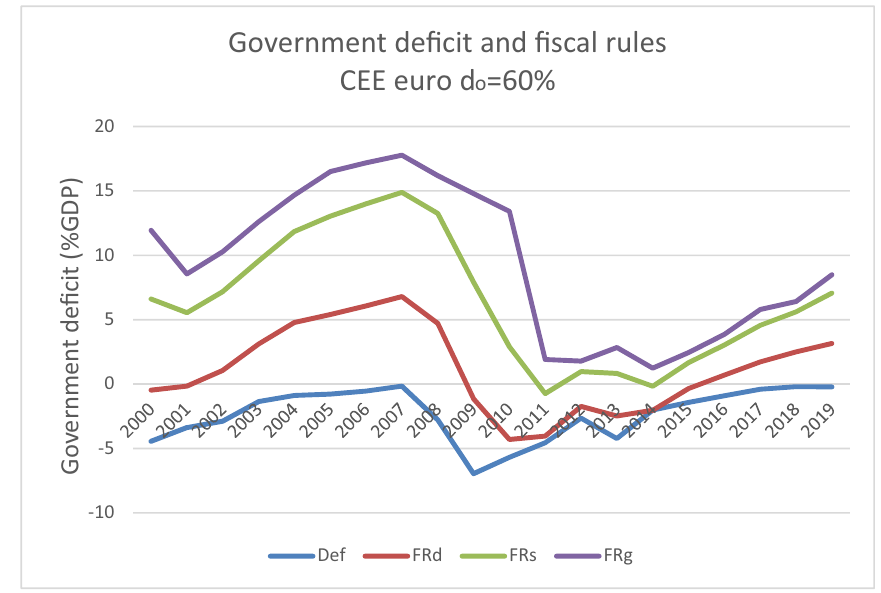
Figure 2.6: CEE € countries government de fi cit ( Source: Own elaboration from data on Table 2 ) .